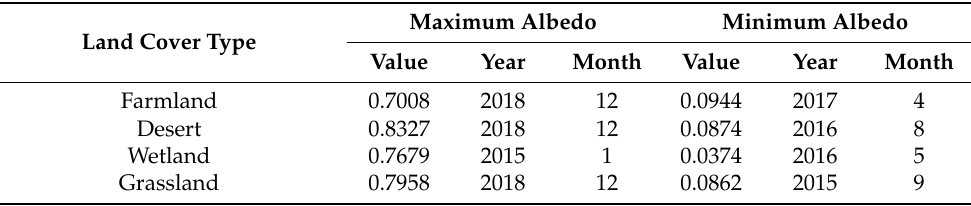
Figure 4. Daily average albedo of four land cover types in Ganzhou. Table 4. Maximum and minimum values of albedo for each land cover